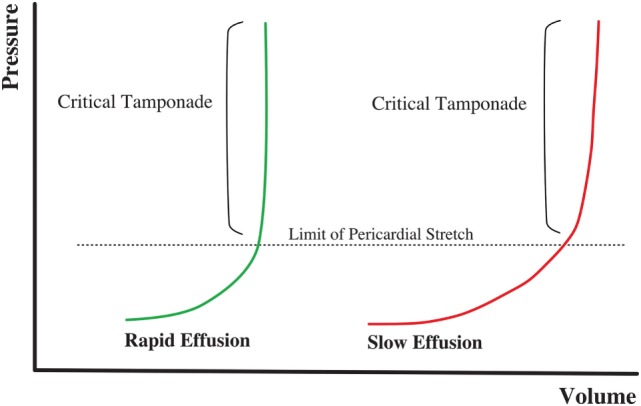
Volume–pressure relationship in cardiac tamponade physiology. Rapid onset effusion leads faster to cardiac tamponade, comparing to a slow increase of the pericardial fluid that will allow the pericardium to stretch reaching the critical point with a higher volume of effusion.